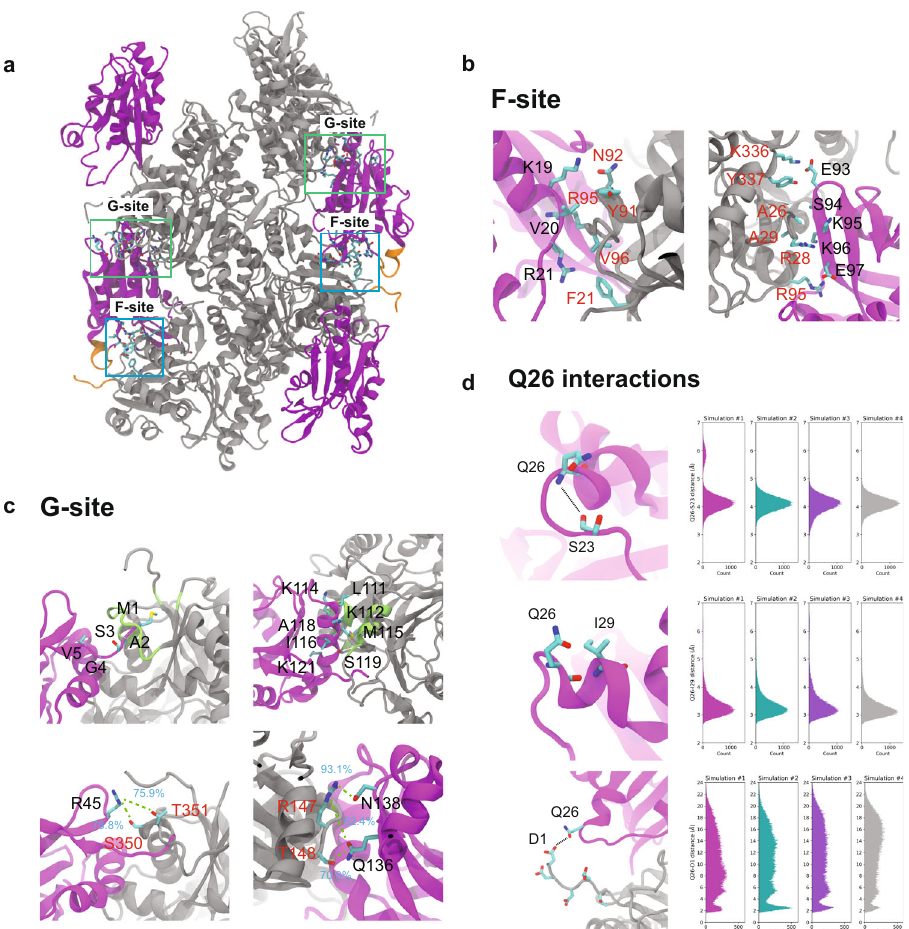
Fig. 3 Co fi lin-actin contacts observed during MD simulations. a The canonical binding sites of co fi lin (magenta)/actin (gray) complex. The G- and F-sites are indicated with green and blue boxes, respectively. The region containing the N-terminus of actin and co fi lin α 2 are shown in orange. b , c CFL2 forms high-occupancy contacts with F-actin through the canonical F-site ( b ) and G-site ( c ) binding modes. b For the F-site on CFL2, these include the NLS, β 4, and the loop preceding β 5. c Residues located in the G-site of CFL2 include the N-terminus, α 4, R45, and α 5. For each binding interface, one representative CFL2 (magenta) and actin (gray) chain are shown. Co fi lin and actin residues in the interaction interfaces are labeled in red and black, respectively. Contact occupancies of selected residues are shown on the structure. d CFL2-Q26 contacts observed during MD simulations. Cartoon representation of inter- residue contacts between Q26 and S23 (top left), I29 (middle left), and actin residue D1 (bottom left). One representative CFL2 (magenta) chain and one representative actin chain (gray) are shown for simplicity. Ensemble of the atomic distances for Q26-S23 (top right), Q26-I29 (middle right), and Q26 – D1 (bottom right) obtained from MD